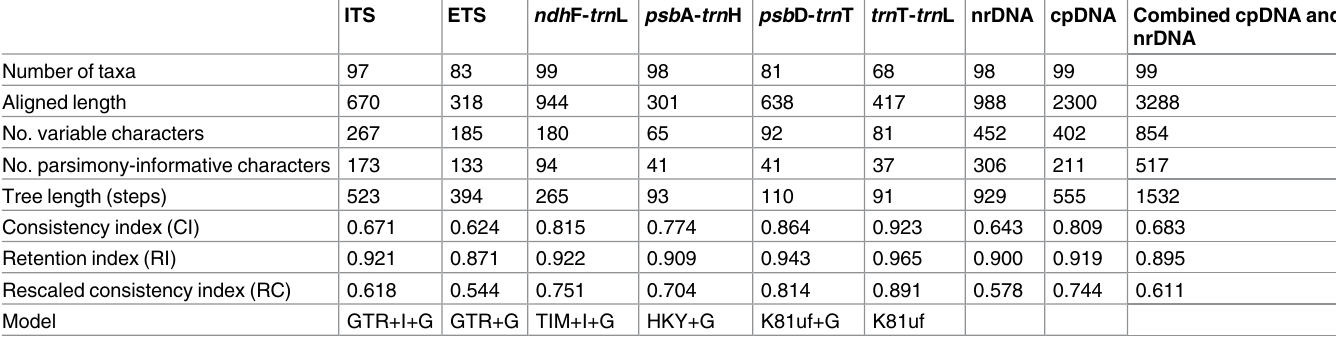
There was no significant incongruence among the four chloroplast regions and the p -values resulting from the ILD test of pairwise sequences are shown in Table 3. Therefore, we com- bined all markers into a single dataset. For the combined cpDNA dataset, information of each aligned DNA data, tree statistics for the MP analysis and the best-fit model of each region are given in Table 4. Table 4. Statistics of the nuclear and chloroplast sequence datasets.